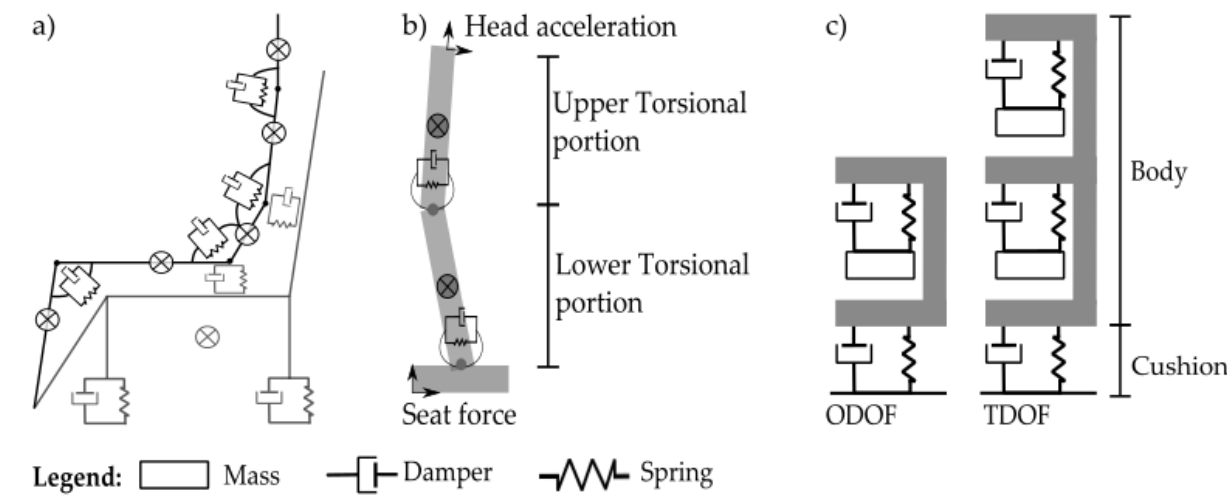
Figure 3. Representation of the mechanical models developed by Kawai et al. and Mastuoka et al. ( a ) Brown et al. ( b ), and Garcia-Mendez et al. ( c ).